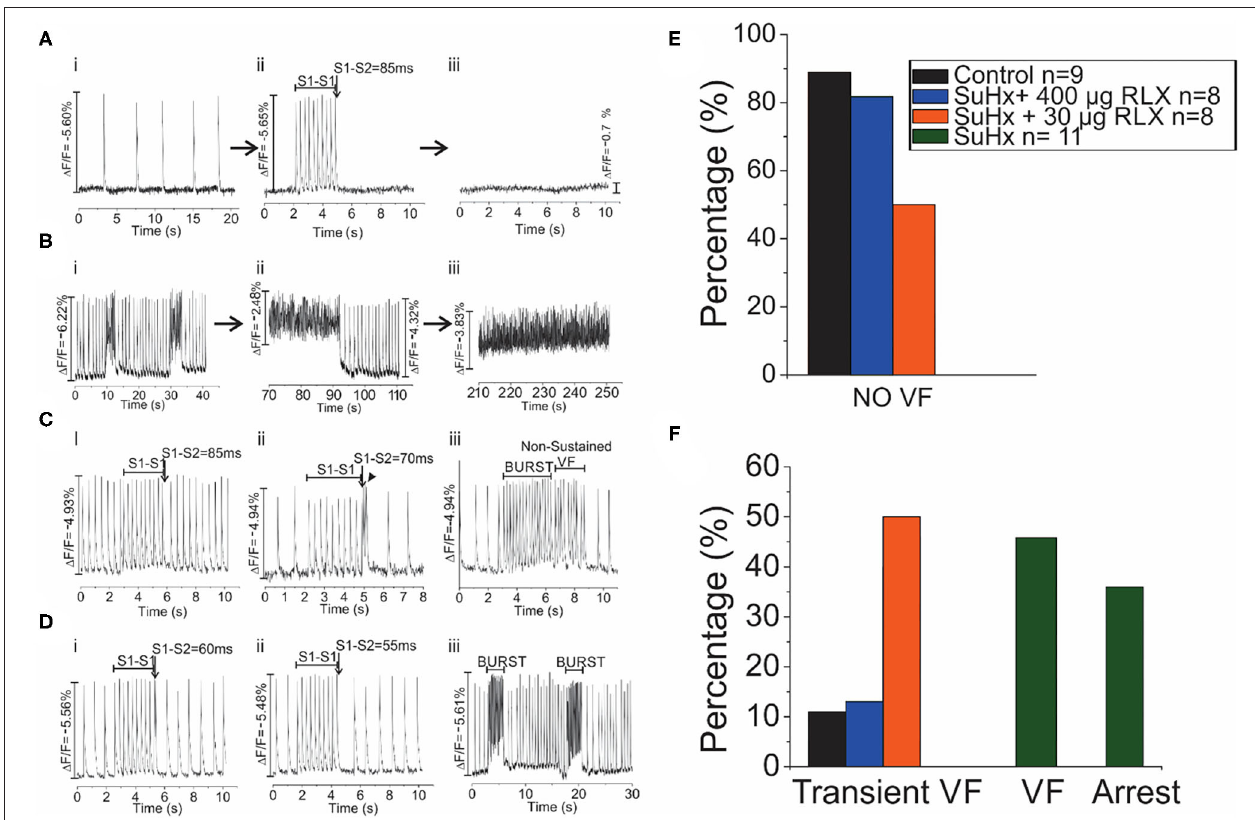
FIGURE 5 | Arrhythmia Phenotypes of PAH hearts. Optical mapping revealed that SuHx hearts exhibited two equally prevalent phenotypes (A,B) . (A) : SuHx hearts were in bradycardia (i) and could be briefly paced at higher rates (ii) which was followed by cardiac arrest (iii) ( n = 4/11). Once in cardiac arrest, electrical stimuli (10X threshold, 1–10ms) failed to capture. (B) : Other SuHx hearts exhibited spontaneous ventricular fibrillations (VF) (i) which increased in durations, were self-terminating (ii) and transitioned to a sustained VF, in this illustration in ∼ 3min) (iii) ( n = 5/11). (C) : In the SuHX + RLX LD (RLX LD) group, Relaxin at low dose suppressed both sustained VF and cardiac arrest ( n = 0/8): (i) AP recordings in sinus rhythm, followed by 2s of rapid pacing and a premature impulse at S1-S2 of 85ms which failed to elicit a VF. (ii) In another SuHx + RLX-LD heart, AP record a bradycardia, followed by rapid pacing and a premature impulse (S1-S2 = 70ms). Here, the premature impulse elicits a brief transient arrhythmia (4 beats) and a return to sinus rhythm. (iii) An example of burst pacing (4s) which elicits a transient VF that self terminates in < 3s. (D) : In the SuHX + RLX HD (RLX HD), Relaxin suppressed cardiac arrest and VF, spontaneous or after burst pacing. (i–ii) examples of rapid pacing